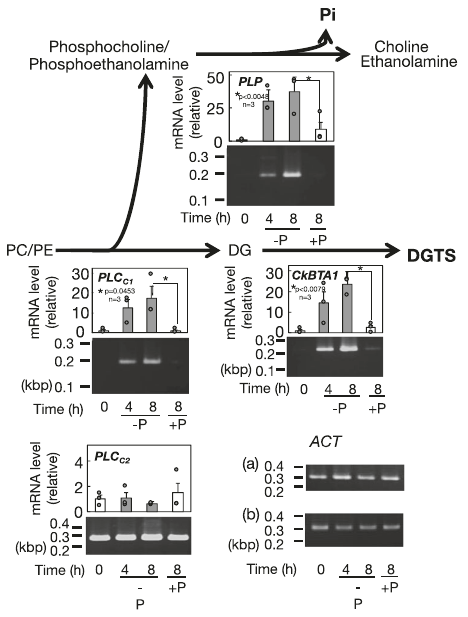
Fig. 9 Regulatory expression of the genes for − P induced lipid remodeling in C. kessleri . The expression levels of the BTA1 , PLC C1 , PLC C2 , and PLP genes were investigated through semi-quantitative RT-PCR analysis in C. kessleri cells before and after a shift to − P conditions. The intensities of the DNA bands that correspond to mRNAs of the individual genes were used for determination of the values, relative to that of ACT . Shown are the values relative to those at 0 h with averages± SEM for three biological replicates. Some dots are overlapped (refer to source data in Supplementary Data 1). Data were analyzed by one-way ANOVA with multiple comparison by Tukey – Kramer ’ s